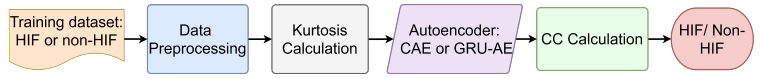
Figure 18. Flowchart for the alternative unsupervised HIF detection models.